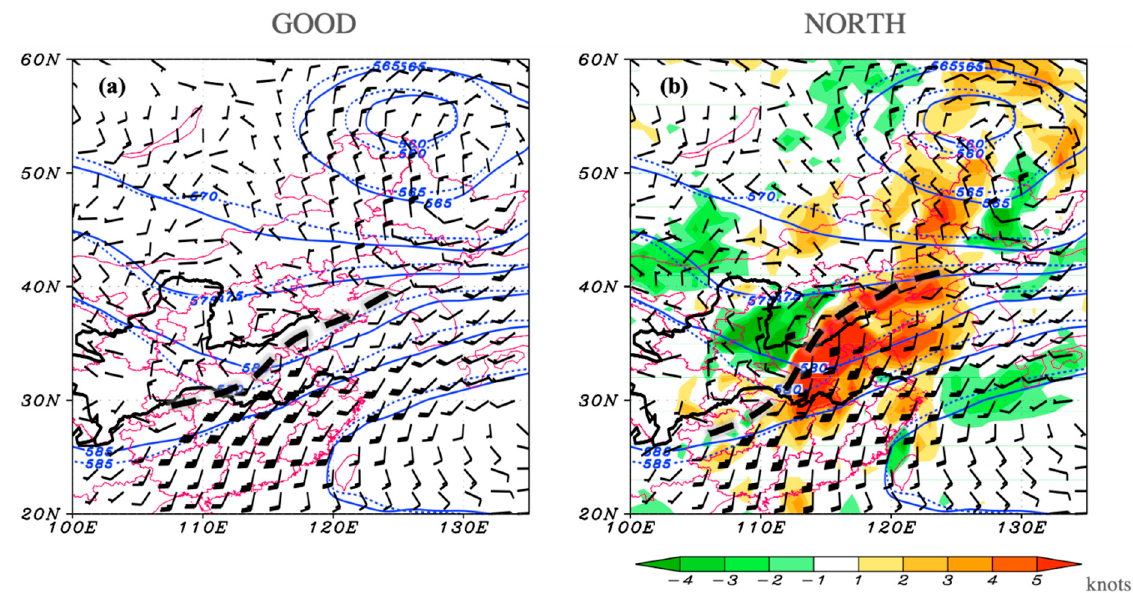
Figure 10. ECMWF EPS subgroup composite mean fields for 0000 UTC 1 July from the forecast initialized at 1200 UTC 28 June 2016. Plotted are the composite 850-hPa vector wind (knots, barbs, typical meteorological convention) of ( a ) the GOOD subset and ( b ) the NORTH subset along with the vector difference between the two fields (knots, colored, panel b, NORTH-GOOD). Also plotted are the composite 500-hPa geopotential heights for the GOOD and NORTH subsets (solid and dashed blue, respectively). The Meiyu Front is objectively identified as the area of maximized horizontal shear at 850 hPa (black dashed lines) for each subset. Thin red contours denote political boundaries and thick black lines denote the Huanghe and Yangtze Rivers to the north and south, respectively.